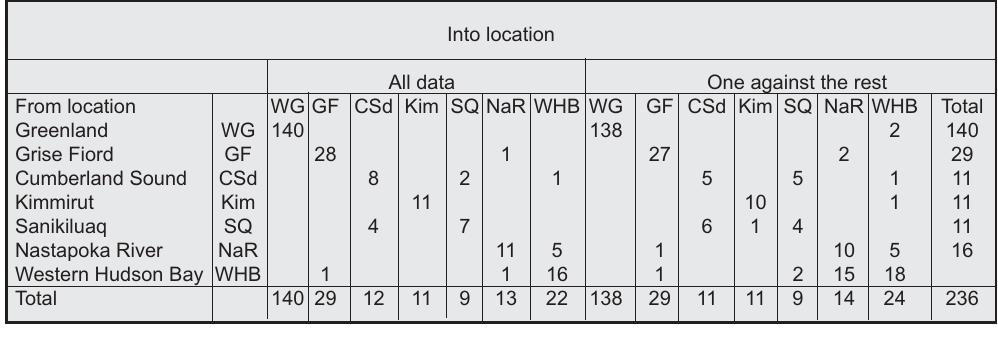
Table 4. Samples discriminated into sampling locations based on the first three Canonical com- ponents. Initially all samples were used (All data), and then each sample was run as an unknown relative to the other samples as a test of